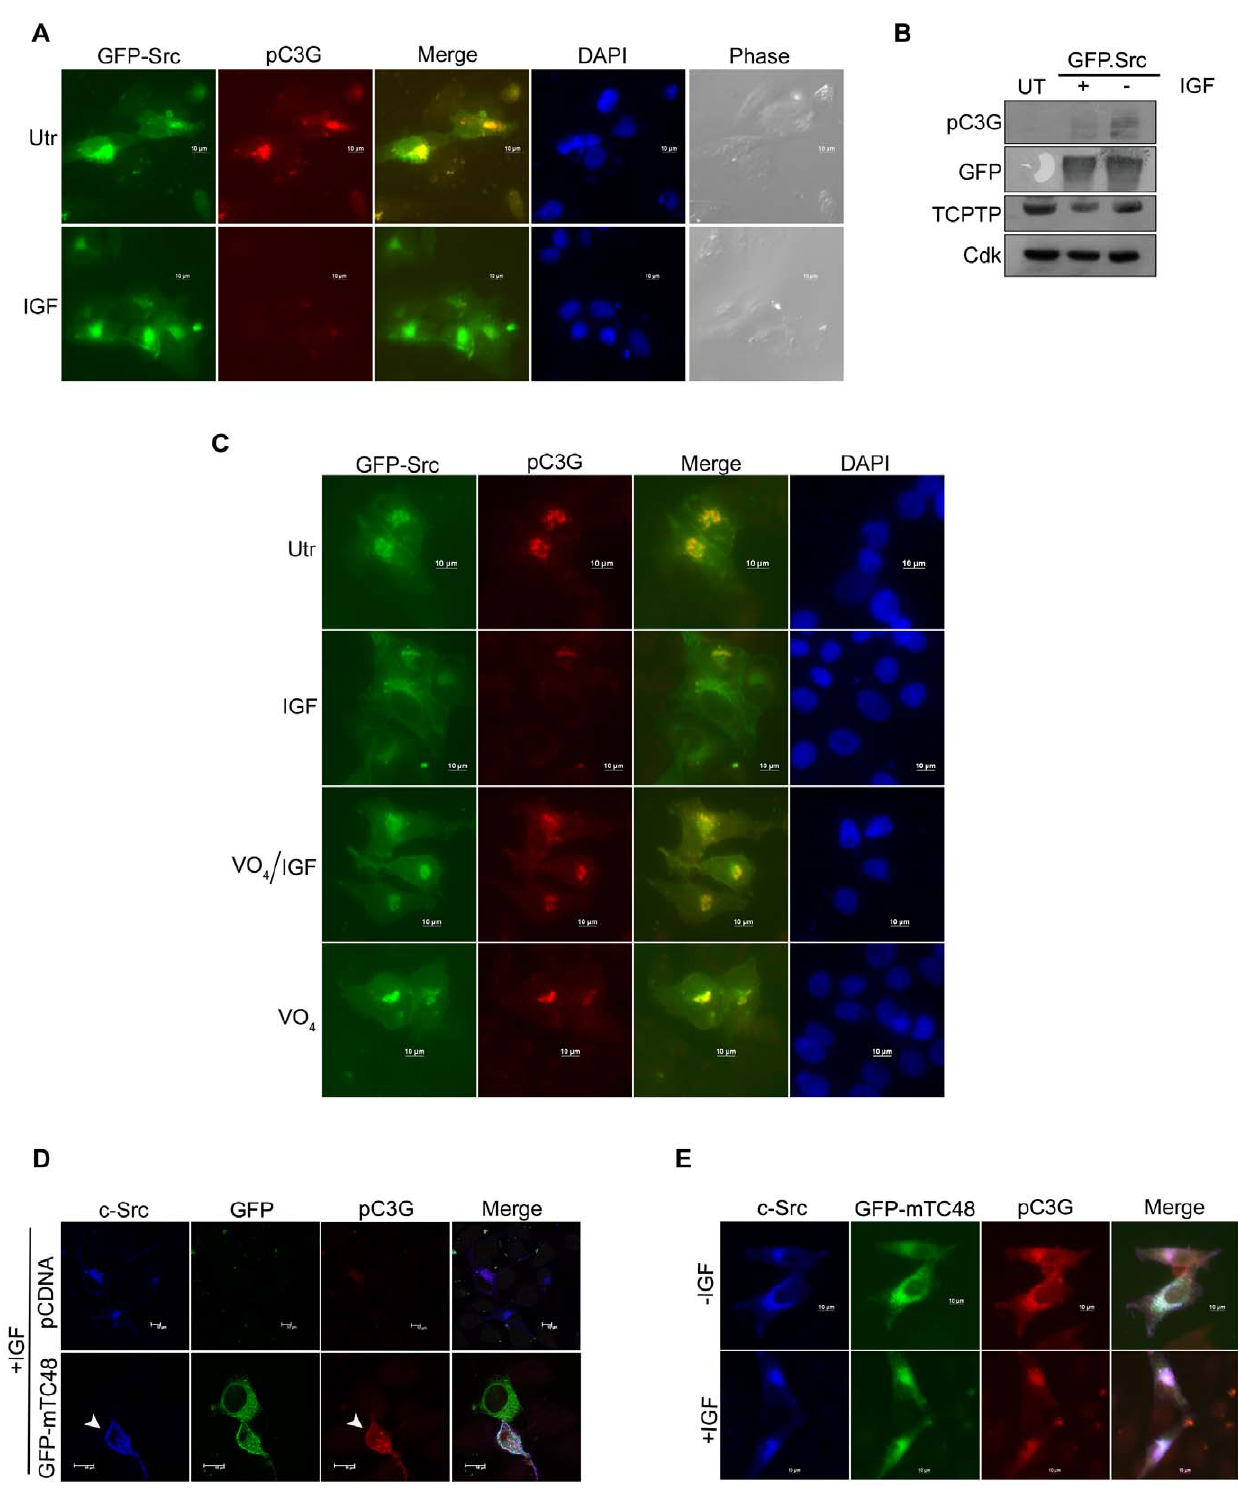
Figure 7. IGF mediated dephosphorylation of C3G is dependent on endogenous TC48. (A) GFP-c-Src expressing IMR-32 cells were treated with IGF prior to fixation and staining for pC3G. Utr, untreated. (B) Lysates of cells treated as in (A) were subjected to western blotting using the indicated antibodies. (C) Pre-treatment with VO 4 abrogates IGF induced dephosphorylation of C3G. GFP-c-Src expressing cells were subjected to IGF treatment with or without VO 4 pre-treatment for 30 min and stained for pC3G. Cells treated with VO 4 alone are also shown. Bar, 10 m m. (D) Expression of GFP-mTC48 along with c-Src, inhibits IGF induced dephosphorylation of C3G. IMR-32 cells were co-transfected with c-Src, and either pCDNA or GFP-mTC48, subjected to IGF treatment and stained for Src and pC3G. Arrow indicates a cell co-expressing mTC48 along with c-Src showing pC3G. (E) mTC48 expressing cells show Src induced pC3G irrespective of their exposure to IGF.